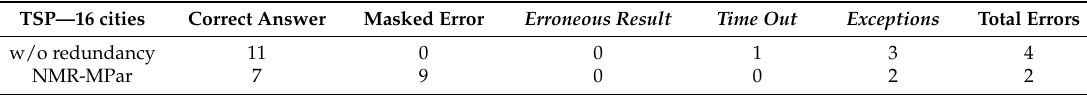
Table 5. SEE Sensitivity of the TSP solving a 16 cities problem.